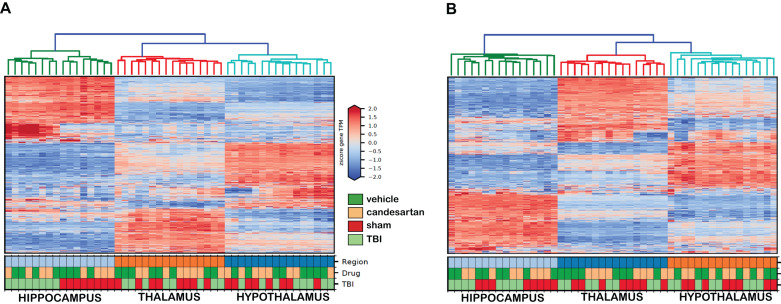
Semi-Supervised Hierarchical Clustering of Genes at 3 and 29 dpi. The top 5,000 genes according to median absolute deviation (MAD) of the gene transcripts per million (TPM) across all samples underwent semi-supervised hierarchical clustering (n = 4/group). Samples clustered primarily by brain region at 3 dpi (A) and at 29 dpi (B).